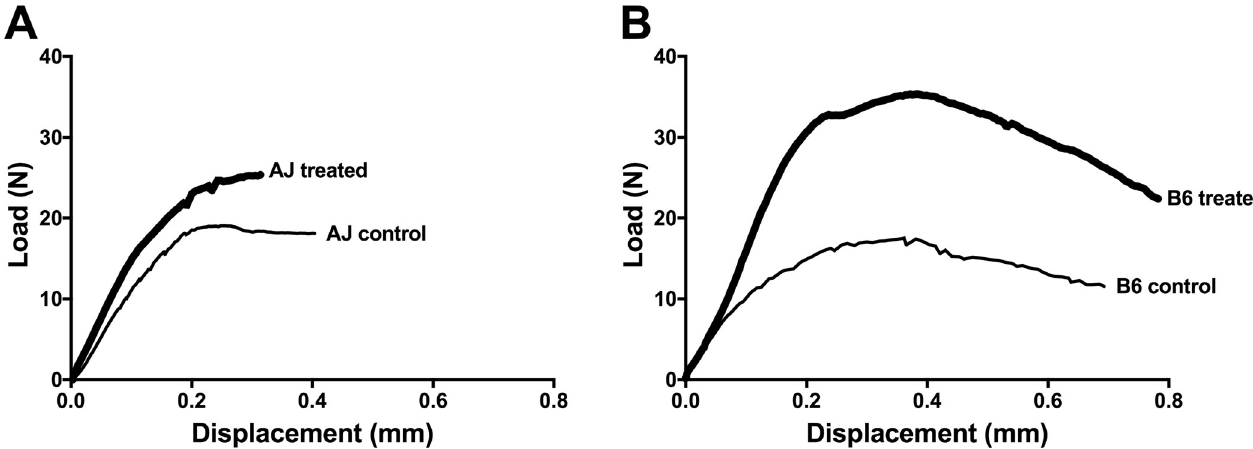
Fig 2. Representative load-deflection curves from four-point bending. A) A/J Veh and A/J Scl-Ab, and B) B6 Veh and B6 Scl-Ab. Stiffness was calculated as the slope of the linear portion of the curve, maximum (max) load was calculated as the highest point on the curve, PYD was the displacement between the end of the linear portion of the curve and the point of failure, and work-to-fracture was calculated as area under the curve put to the point of failure.